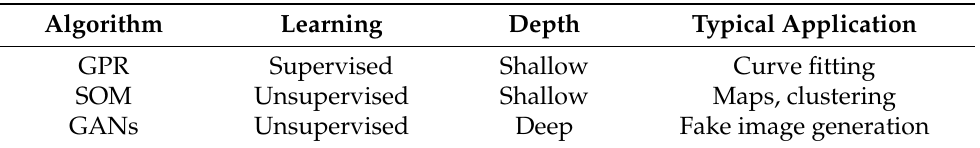
Table 4. ML algorithm summary with learning type and neural network depth. A network is said to be deep if it contains two or more hidden